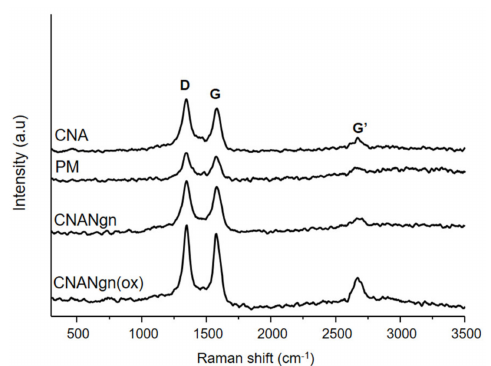
Figure 4. Raman spectra of CNA (CNT after acid treatment), CNANgn (CNA treated with naringenin), CNANgn(ox) (CNA treated with naringenin in oxidative environment) and PM (physical mixture of CNA and naringenin).